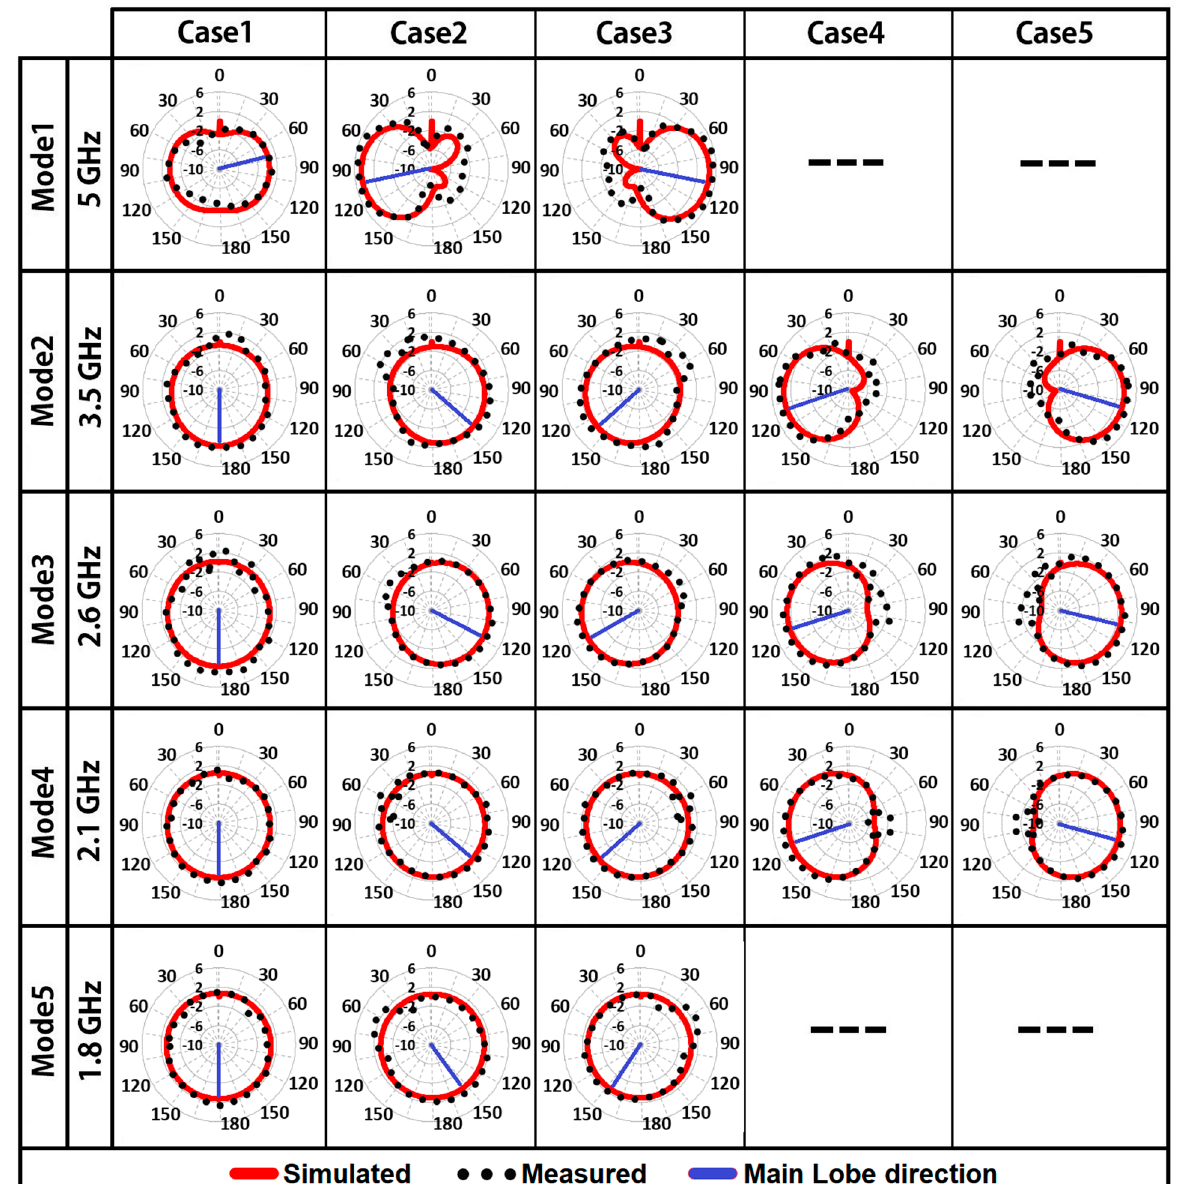
Figure 11. Polar plots for all modes (at Phi = 0, x–z plane).